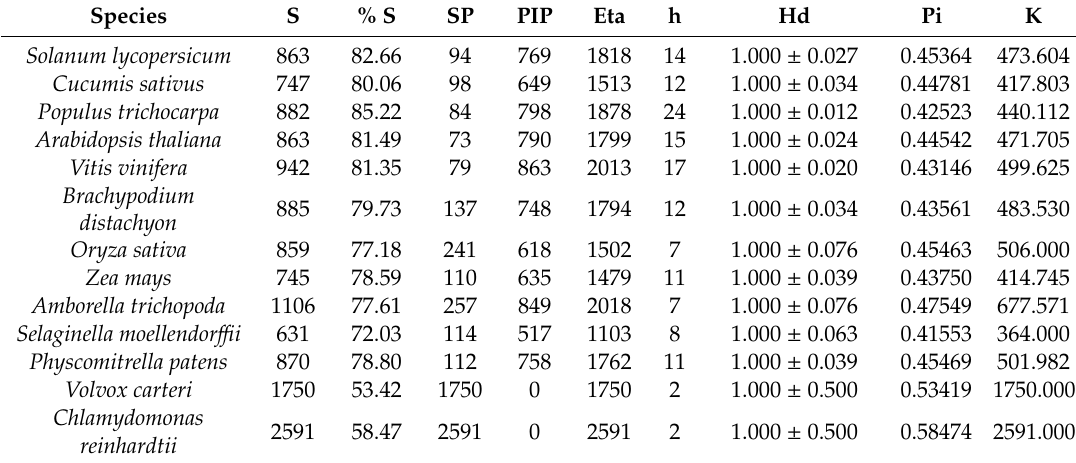
Table 3. Intra-species polymorphism and haplotype diversity of MLO